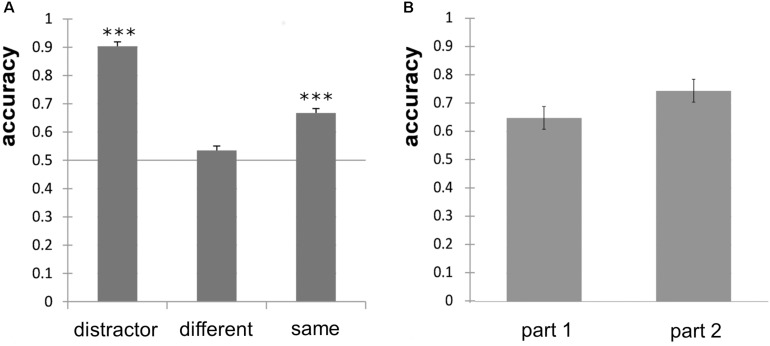
(A) Odor discrimination accuracy of the distractor odor pairs, different odor pairs and same odor pairs and significance against chance level of 0.5 (∗∗∗p < 0.001). (B) Non-significant improvement of odor discrimination performance for part 1 (first half) and part 2 (second half) of the experiment; error bars show standard error of the mean.